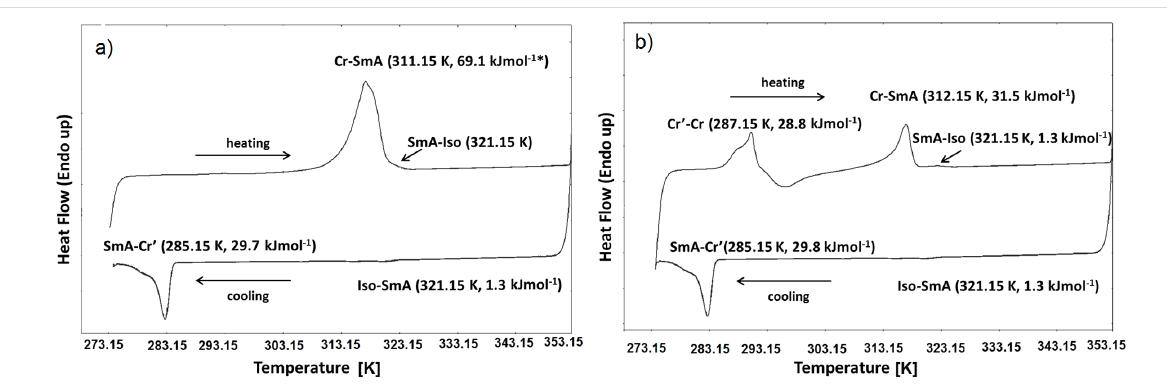
Figure 3: DSC traces for [bisC 8 ImC 10 ][C 12 H 25 OSO 3 ] 2 : (a) first and (b) second heating–cooling cycle recorded in the temperature range of 273–353 K with a scan rate of 10 K/min. Thermal parameters are given in brackets. The given enthalpy contains the combined values for the two transitions Cr–SmA and